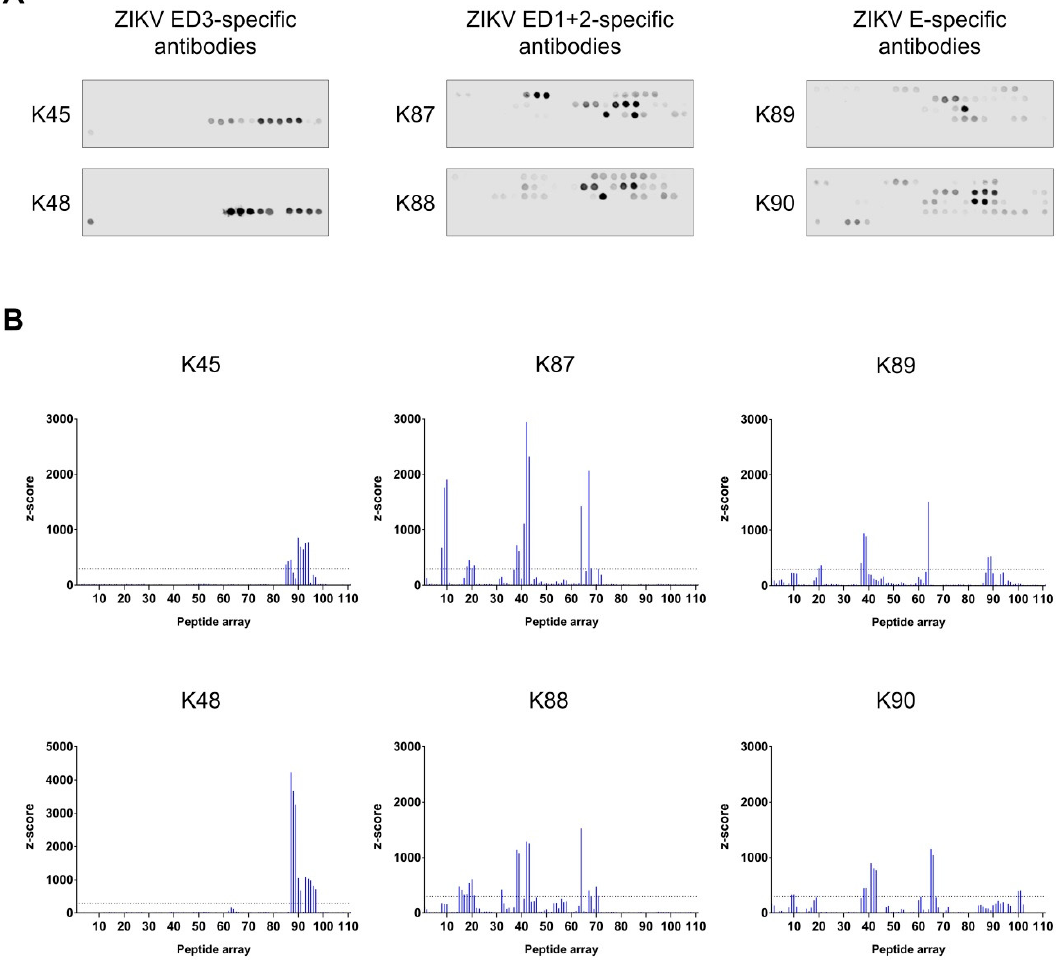
Figure 6. Binding sites determination of the purified antibodies. ( A ) The arrays with spotted peptides were incubated with the purified antibodies (K45–K90), followed by incubation with secondary antibody and scanning; ( B ) The results from the peptide arrays (in A ) are illustrated on graphs in which the peptide number is shown on the X-axis and the z-score is shown on the Y-axis. The dotted lines represent the cut-off.